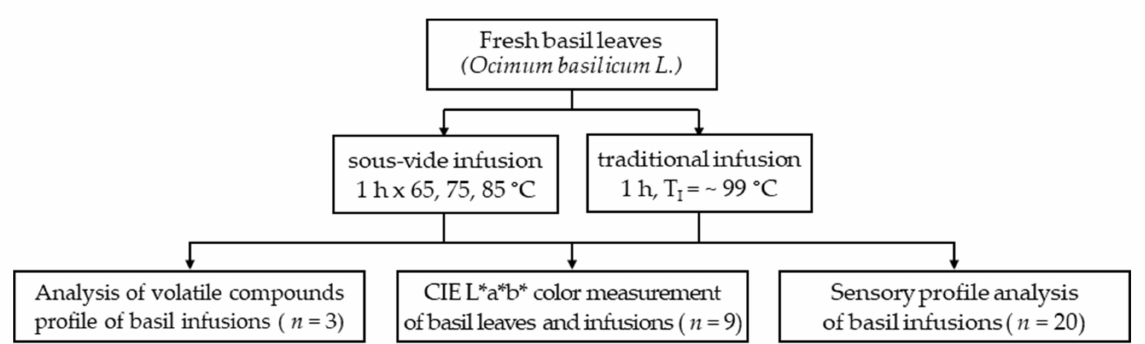
Figure 2. Study design (T I —initial